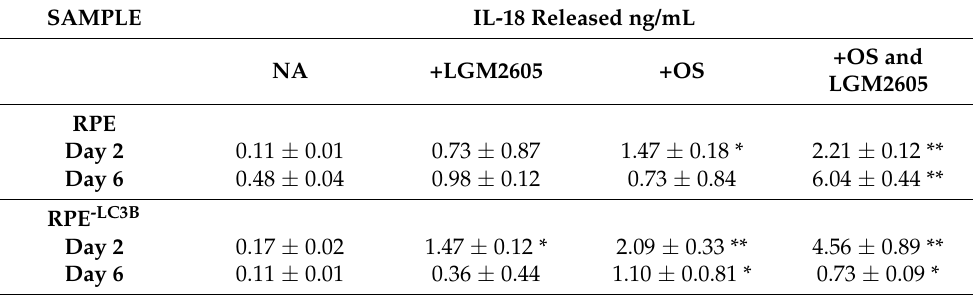
Table 1. IL-18 released into apical supernatant. RPE or RPE -LC3B cells were incubated once daily for 7 days. Each day of a 7-day long study, cells were either left untreated, pretreated with LGM2605 (100 µ M) or challenged with OS, with or without (LGM2605 (100 µ M) pretreatment. IL-18 released into the apical media as measured by ELISA at day 2 and day 6 is indicated. Data shown is the mean ± SEM of three independent experiments, each in duplicate. * p < 0.050, and ** p < 0.020. SAMPLE IL-18 Released